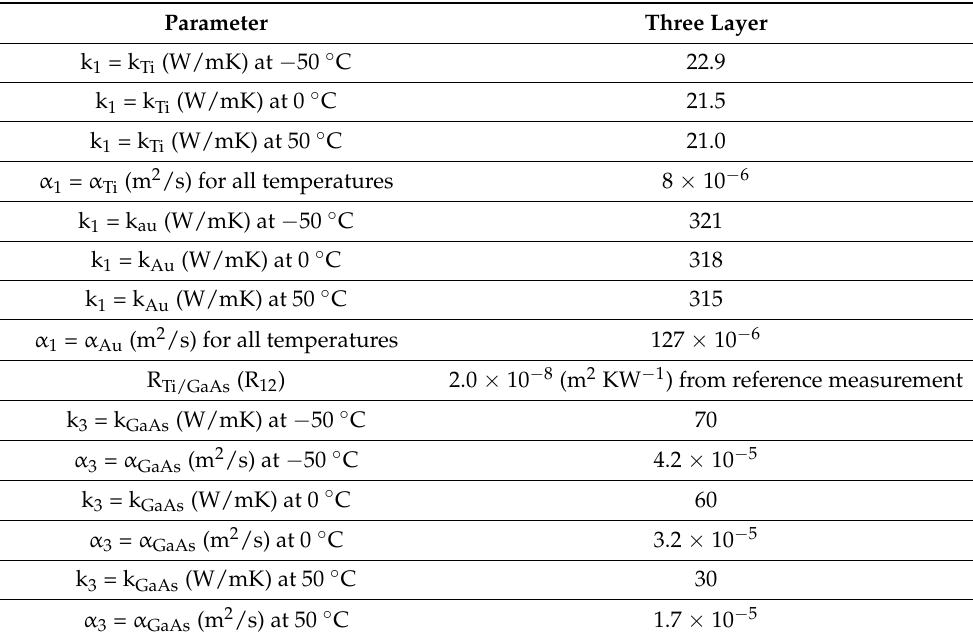
Table 2. Constant parameters used for